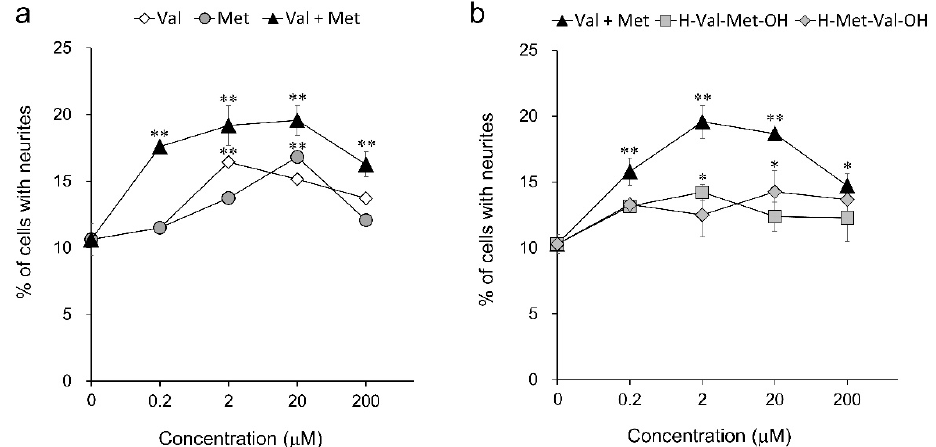
Figure 5. Neurite outgrowth-promoting activities of valine, methionine, their mixture, and their dipeptide in the presence of Bt 2 cAMP in PC12 cells. ( a ) Promoting activities of valine and methionine and a mixture of equal amounts of valine and methionine for neurite formation induced by Bt 2 cAMP in PC12 cells. ( b ) Promoting activities of a mixture of equal amounts of valine and methionine and their dipeptides (H-Val-Met-OH, H-Met-Val-OH) for neurite formation induced by Bt 2 cAMP in PC12 cells. PC12 cells were plated at 4.0 × 10 3 cells/well and cultured with the samples at concentra- tions of 0.2–200 μ M in the presence of 0.5 mM of Bt 2 cAMP. The extent of neurite outgrowth was measured at 24 h and is expressed as the mean percentage of 300–400 cells. The data represent means ± standard deviation (SD) from three independent experiments. * p < 0.05, ** p < 0.01 (Dunnett’s test), as compared with the control (0.5 mM Bt 2 cAMP only).